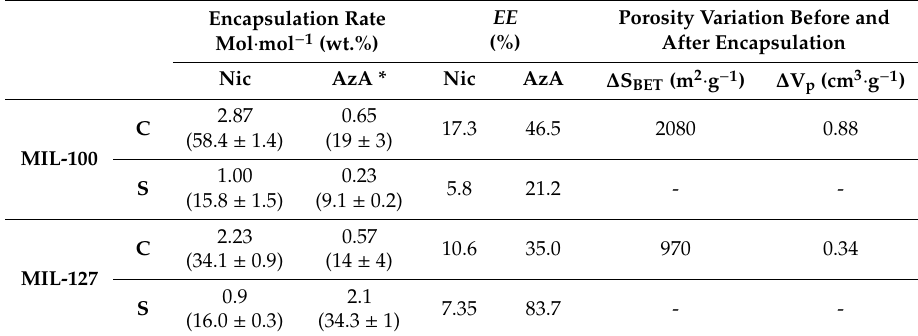
Table 1. Nic and/or AzA encapsulation loading, encapsulation efficiency ( EE ), and variation in BET surface areas (S BET ) and pore volume (V p ) after drug encapsulation in MIL-100 and MIL-127 Fe-based MOFs.